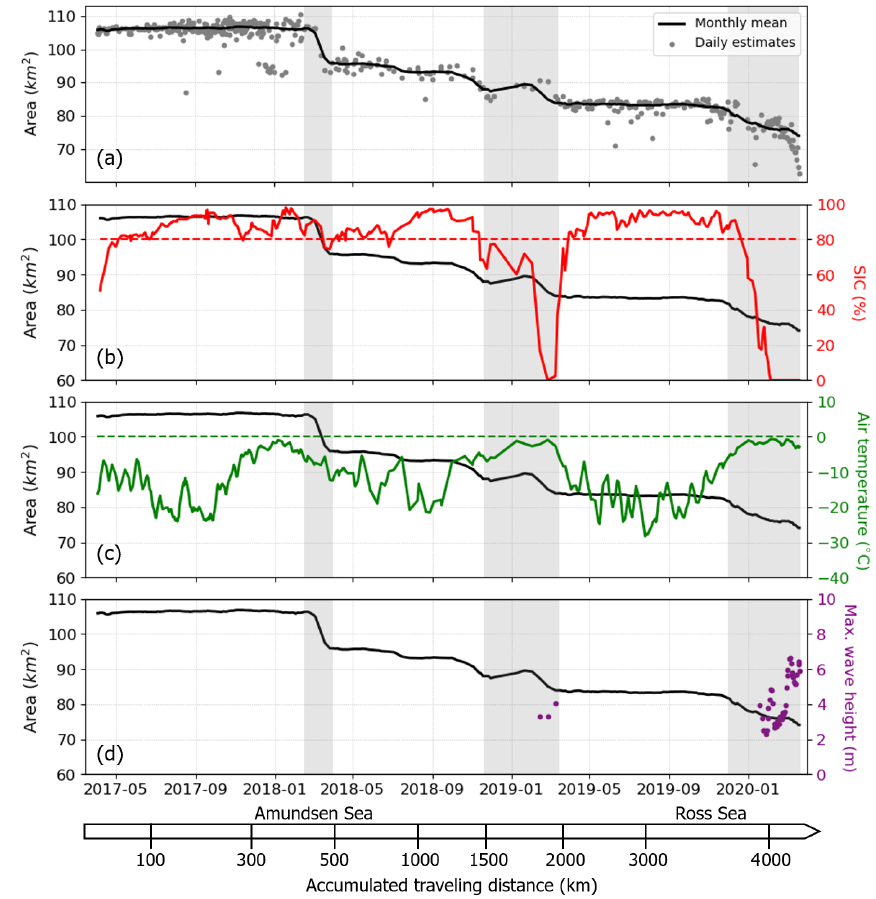
Figure 8. (a) Temporal changes of the iceberg area from April 2017 to March 2020. Comparison of area changes of the iceberg (black line) with (b) sea ice concentration (SIC) (red), (c) air temperature (green), and (d) maximum wave height (purple) from ERA5. Wave heights are not calculated for unmarked periods because the high SIC effectively dampens waves. Gray shaded areas indicate the split-off events of the iceberg. Table 1. Freeboard and thickness of the iceberg estimated by ICESat-2 (IS2) and CryoSat-2 (CS2). Date Data Latitude Longitude